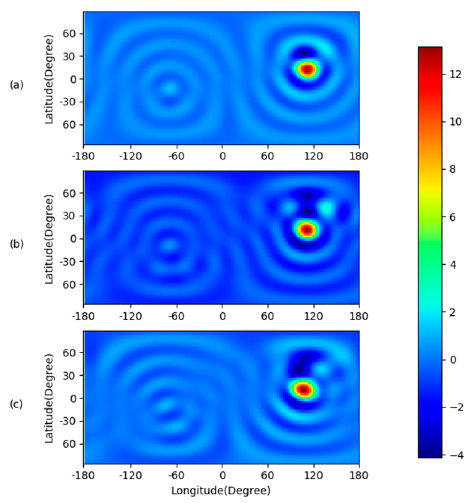
Figure 6. Differences between RRTGIM-1 ( a ), RRTGIM-3 ( b ), and RRTGIM-6 ( c ) and CNES.